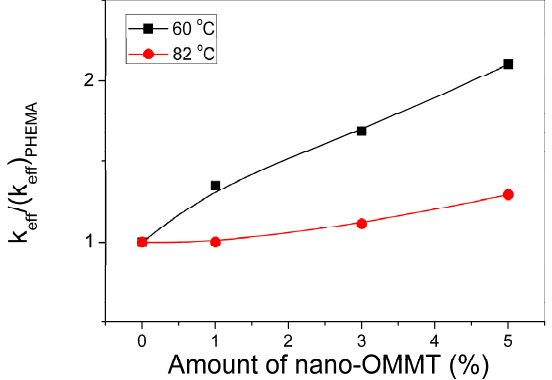
Figure 8. Relative effective kinetic rate constants obtained during polymerization of PHEMA/n-OMMT nanocomposites at two temperatures as a function of the amount of